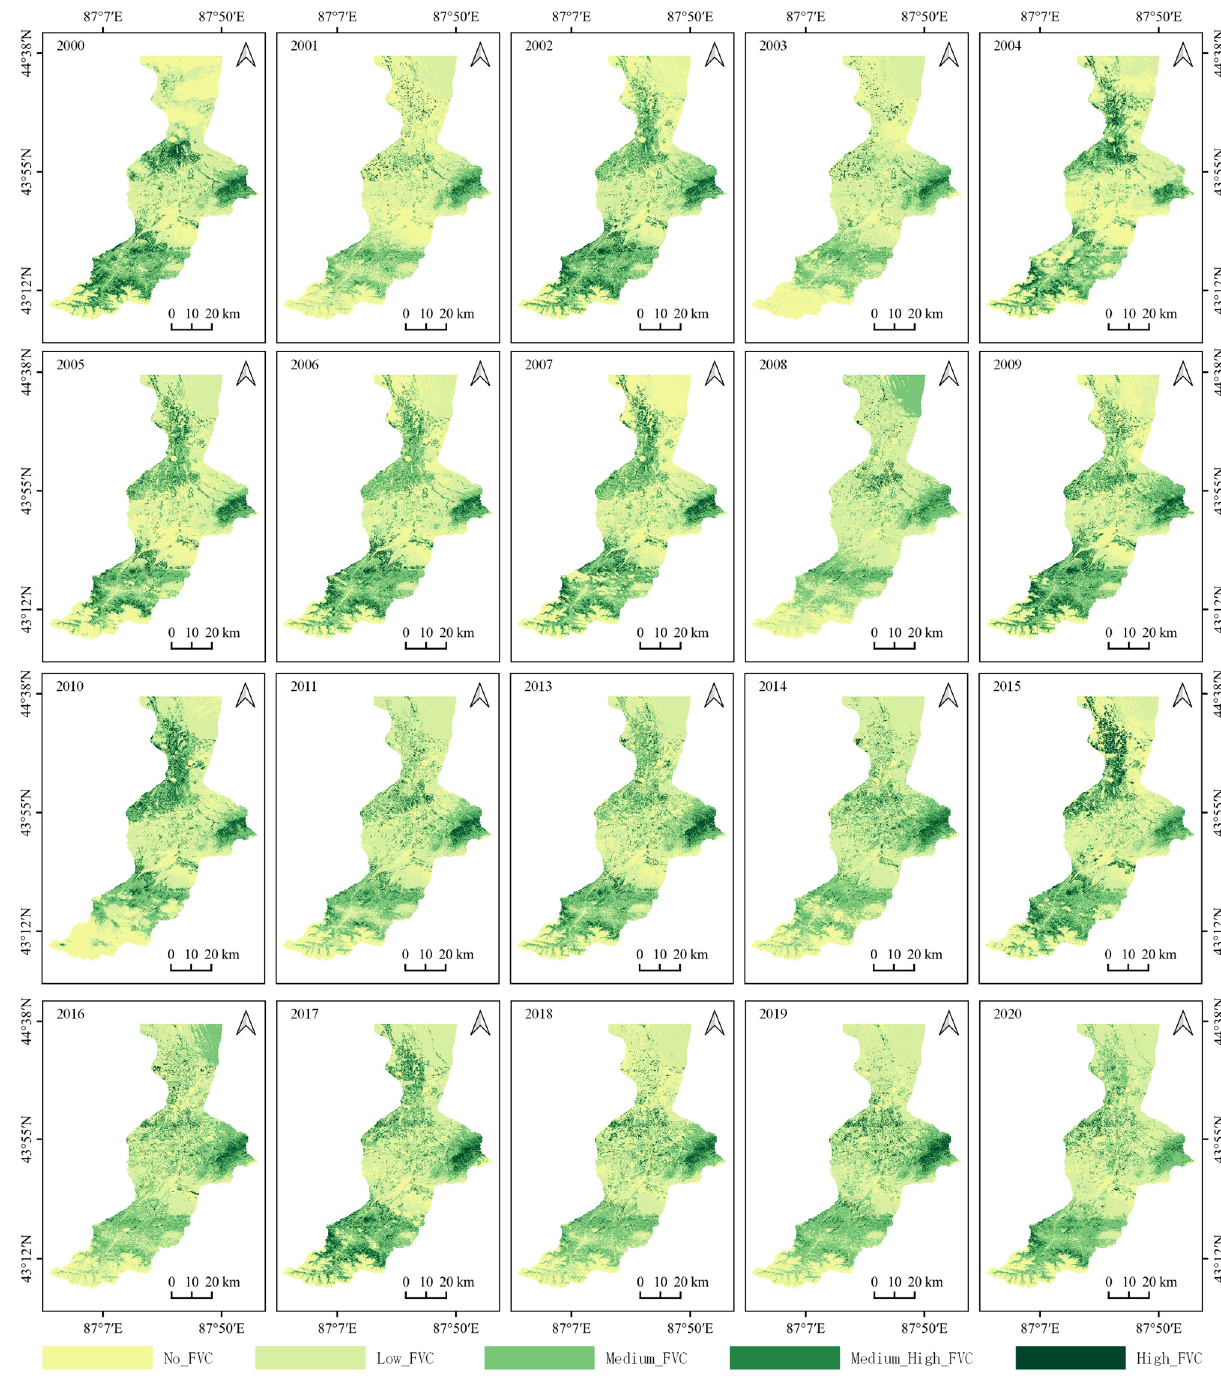
Figure 4. Annual changes in the distribution of vegetation coverage from 2000 to